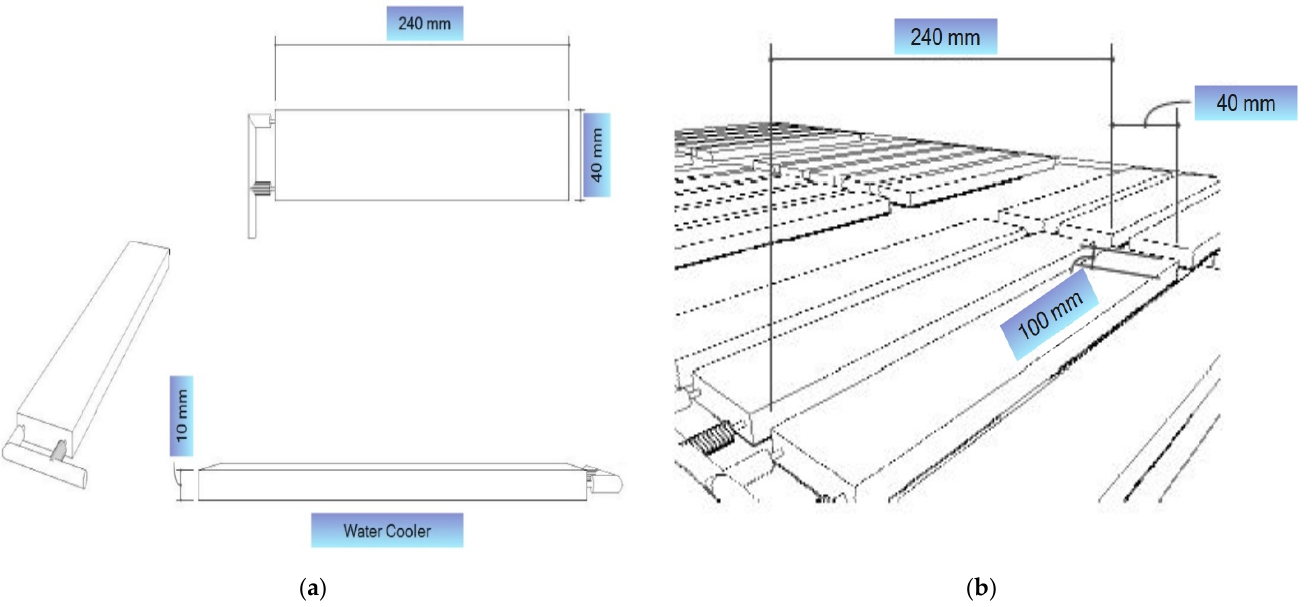
Figure 4. ( a ) Schematic diagram of CLYXGS aluminum water block, and ( b ) individual pieces comprising an aluminum water block in the as-built system.